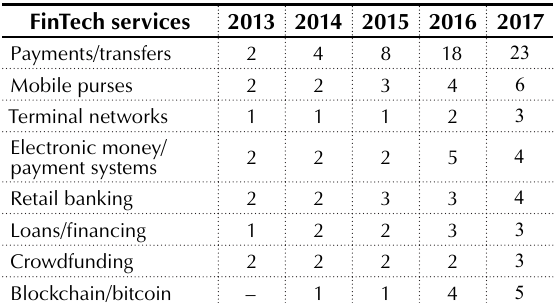
Table 1. Dynamics of the number of